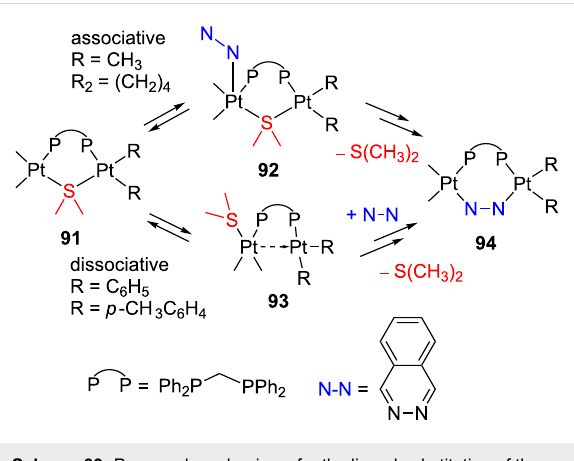
Dissociative ligand